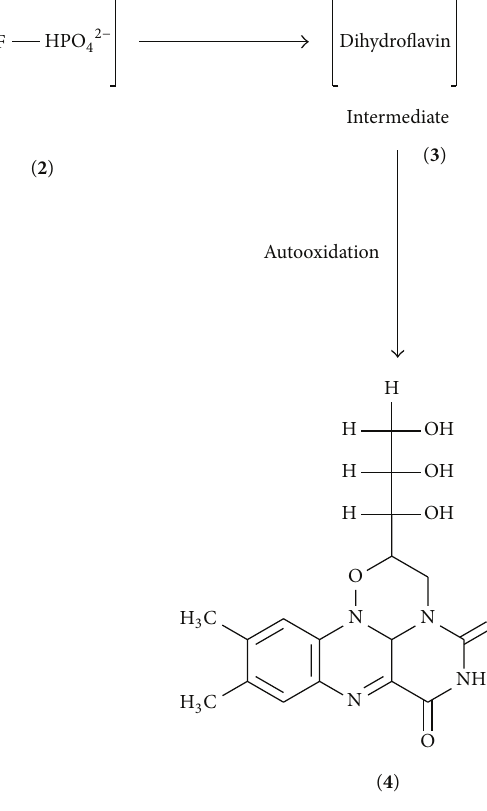
Figure 1: Photoaddition reactions of